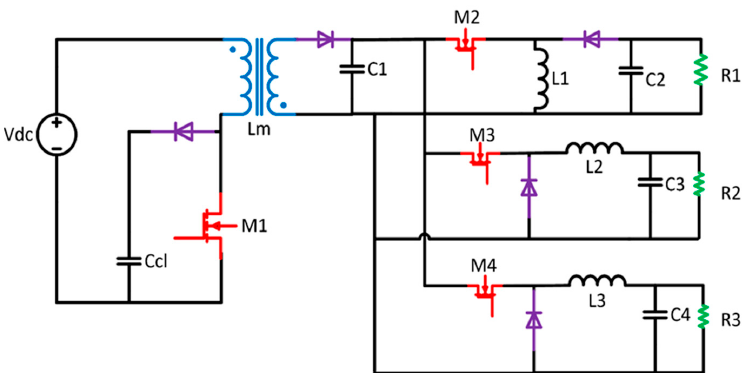
Figure 3. Complete circuit topology including front end Flyback converter for 0–240 V loads.